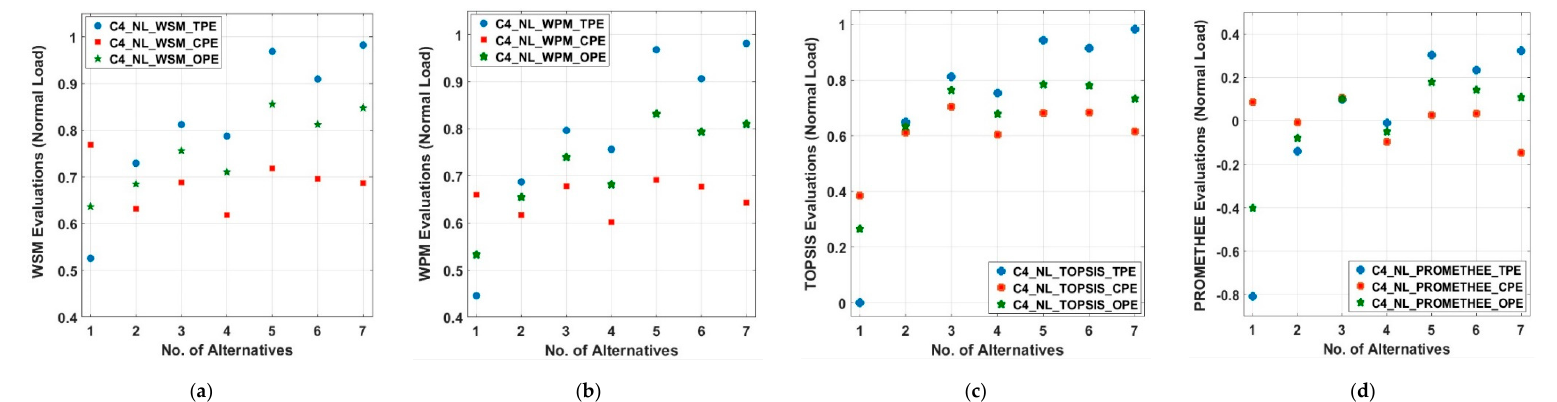
Figure 8. MCDM evaluations for C4_NL in 33-bus MDN: ( a ) WSM scores; (b) WPM scores; ( c ) TOPSIS scores; ( d ) PROMETHEE scores. Table 12. Order of the ranks across TPE, CPE, and OPE in C4_NL for 33-bus MDN.